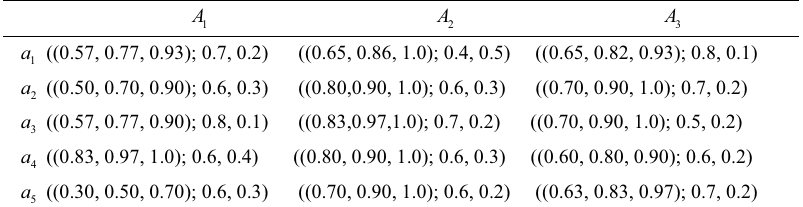
Table 4 The normalized TIFN decision matrix given by A 1